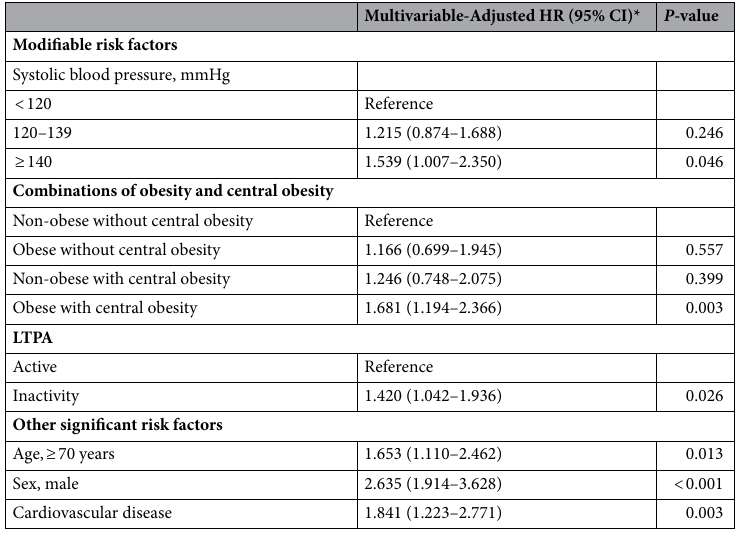
Table 2. Risk factors for incident atrial fibrillation using a time-updated model. HR, hazard ratio; CI, confidence interval; LTPA, leisure time physical activity. *Multivariable adjustment was for sex, area and time- updated assessment of age, systolic blood pressure, combinations of obesity and central obesity, LTPA, chronic kidney disease, cardiovascular disease, HbA1c and total cholesterol.